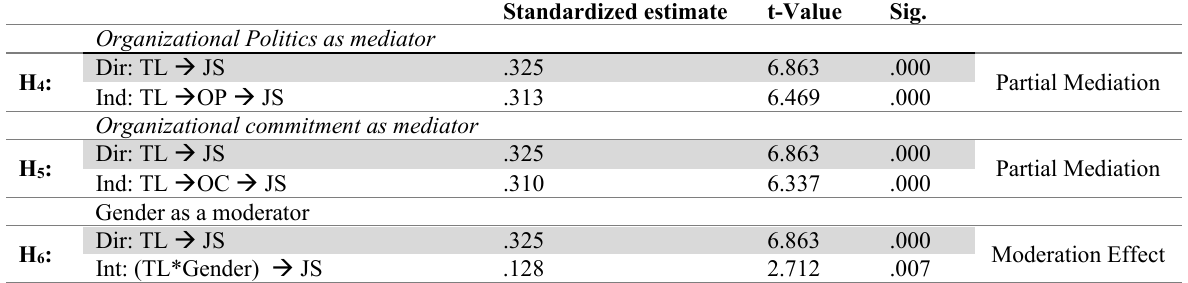
Analysis of mediator and moderator test results